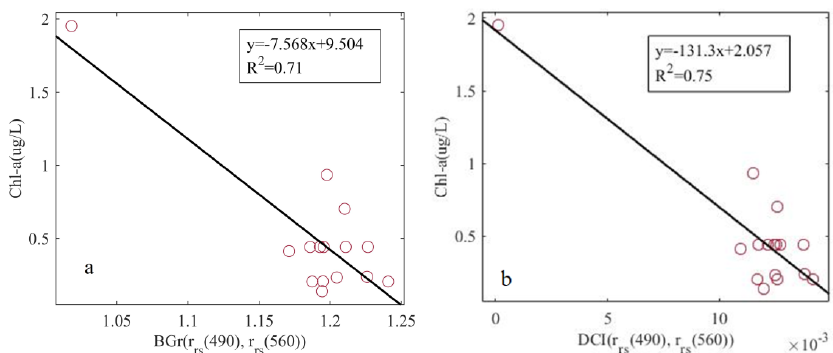
Figure 10. Scatterplots of the Chl-a concentration as a function of ( a ) BGr calculated by r rs (490) and r rs (560), and ( b ) DCI calculated by r rs (490) and r rs (560). For the BGr and DCI algorithms, the effect of NAP may be the most important factor for Chl-a concentration retrieval, because the absorption of NAP in the blue and green bands is much larger than the absorption of Chl-a. We applied the semi-analytical algorithm based on a phy (490) to reduce the effect of NAP, and the accuracy of algorithm was improved (R 2 = 0.91 as shown in Figure 11). The retrieval results using a phy (660) inverted by the semi-analytical algorithm were not as good as those using a phy (490), which may be because the wavelength range of the SPOT6 red band (625–695 nm) contains not only a strong Chl-a spectral absorption, but also a weak Chl-a spectral reflection (as shown in Appendix A1).